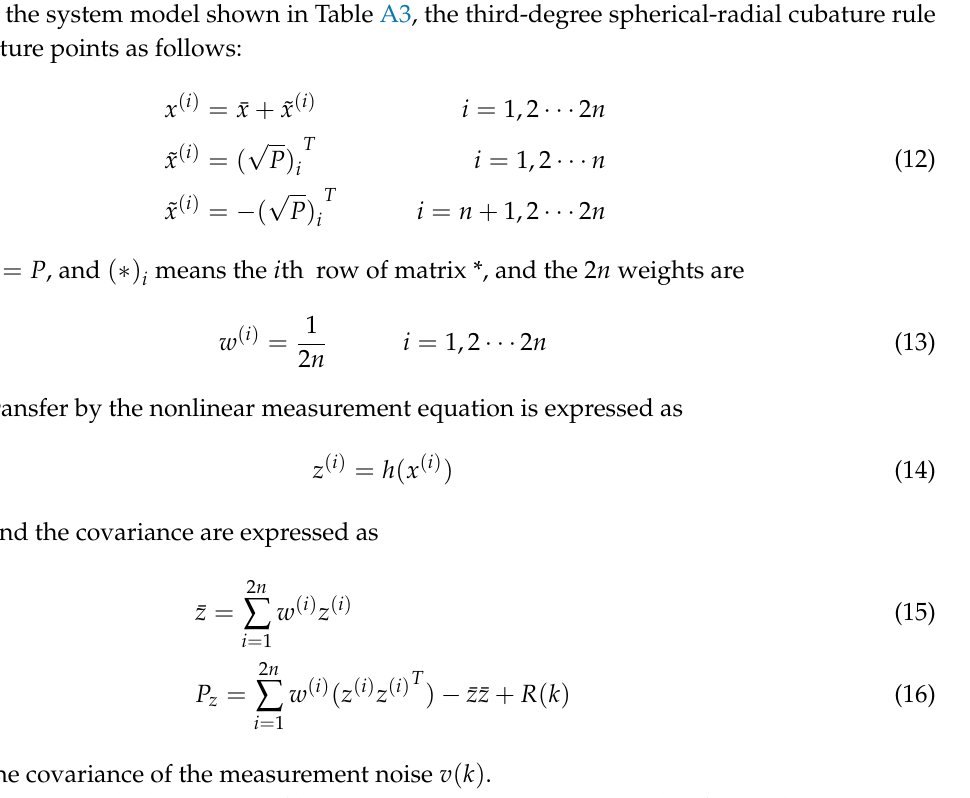
Table A2 details the UKF estimation method. The sigma points used for the prediction of the state with the weights, and the update of the state with the filter gain, are shown in this table. Finally, the prediction and update processes for the covariance are also